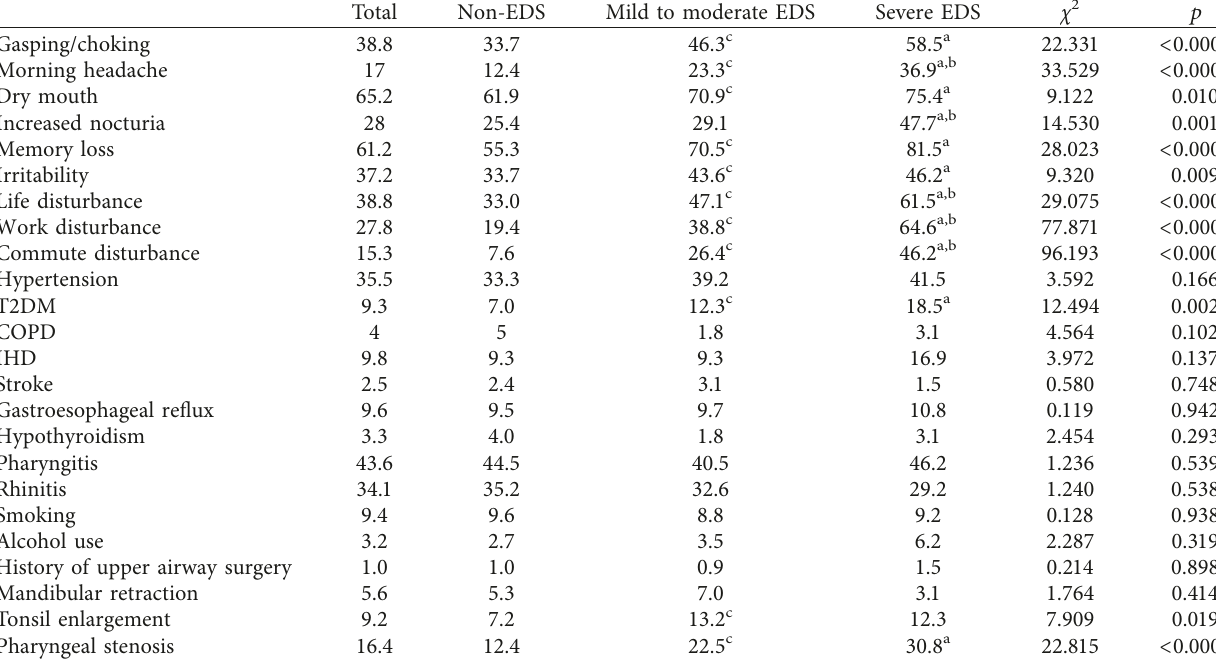
Table 2: Clinical manifestations and comorbidities of the total OSA patients and the patients with different severities of EDS.